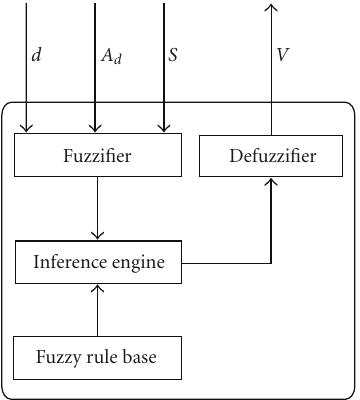
Figure 1: The fuzzy speed prediction